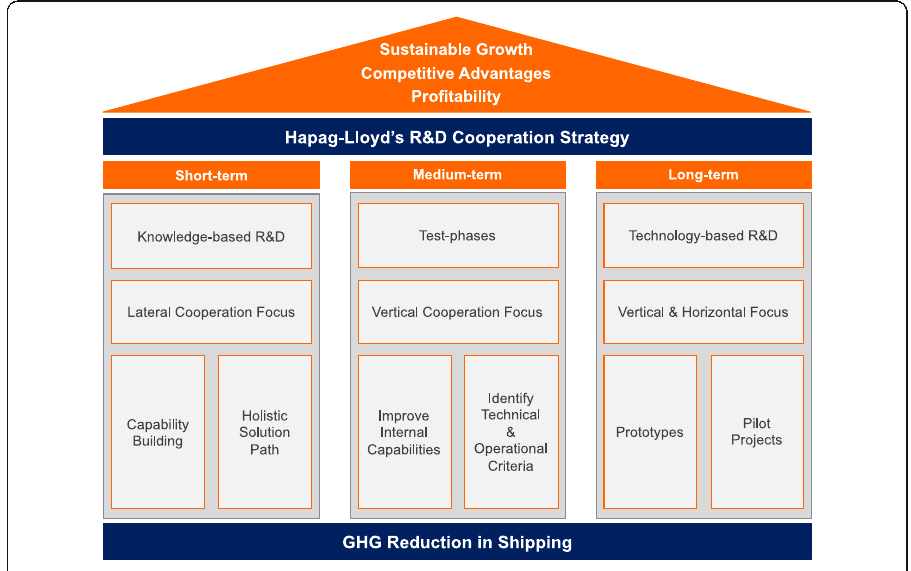
Fig. 3 Cooperation Partner Scoring Risk Assessment (Own